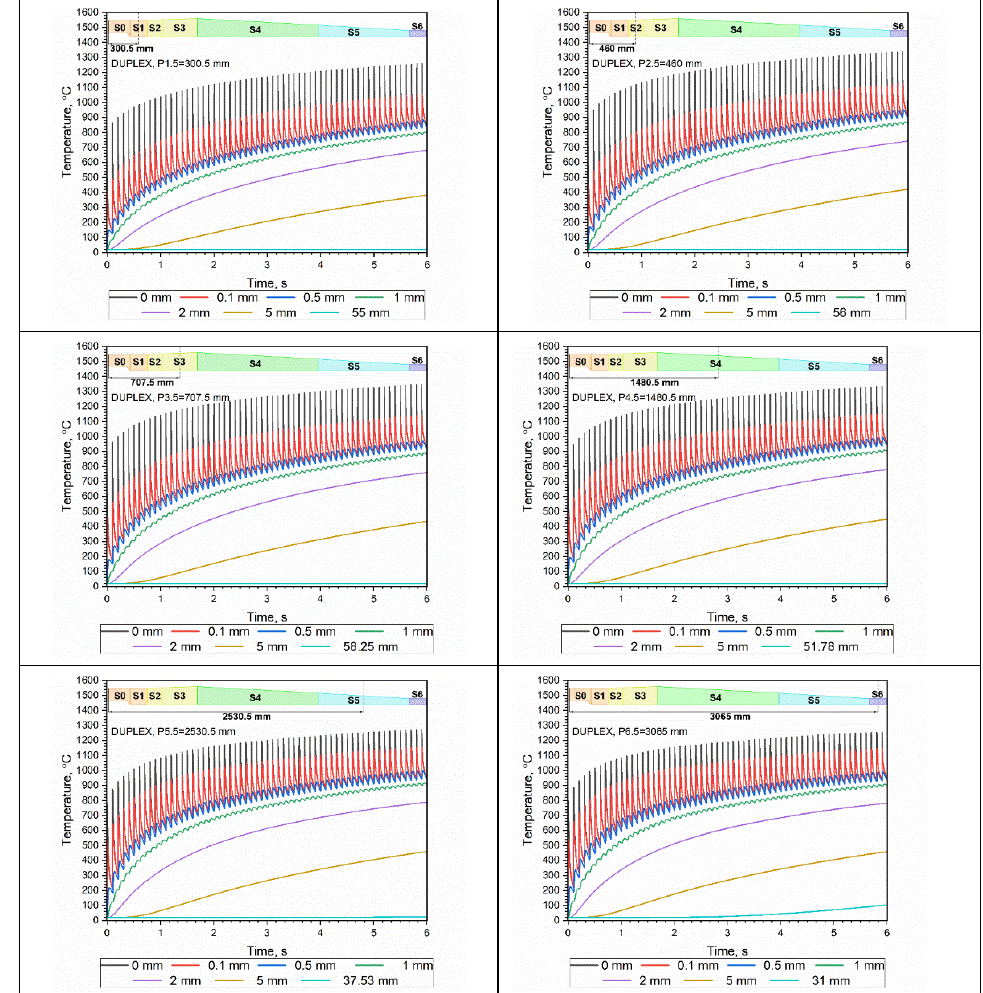
Figure 13. Temperature distribution T i ( t , r w , z ) along the barrel thickness at the zones S1 to S6 ( z in the middle of each zone) for the sequence of sixty shots, for the DUPLEX steel: black line—on the inner surface of the barrel, red line—0.1 mm below the inside surface, blue line—0.5 mm below the inside surface, green line—1 mm below the inside surface, violet line—2 mm under the inner surface, yellow line—5 mm under the inner surface, light blue line—on the outer surface of the barrel. The signs: P1.5—in the middle of the S1 zone, P2.5—in the middle of the S2 zone, etc. Figure 14 shows the envelopes of the so-called highest peak temperatures and lowest peak base temperatures for 60 shots for all selected steels. For 38HMJ and 30HN2MFA steels, the lines match blue.